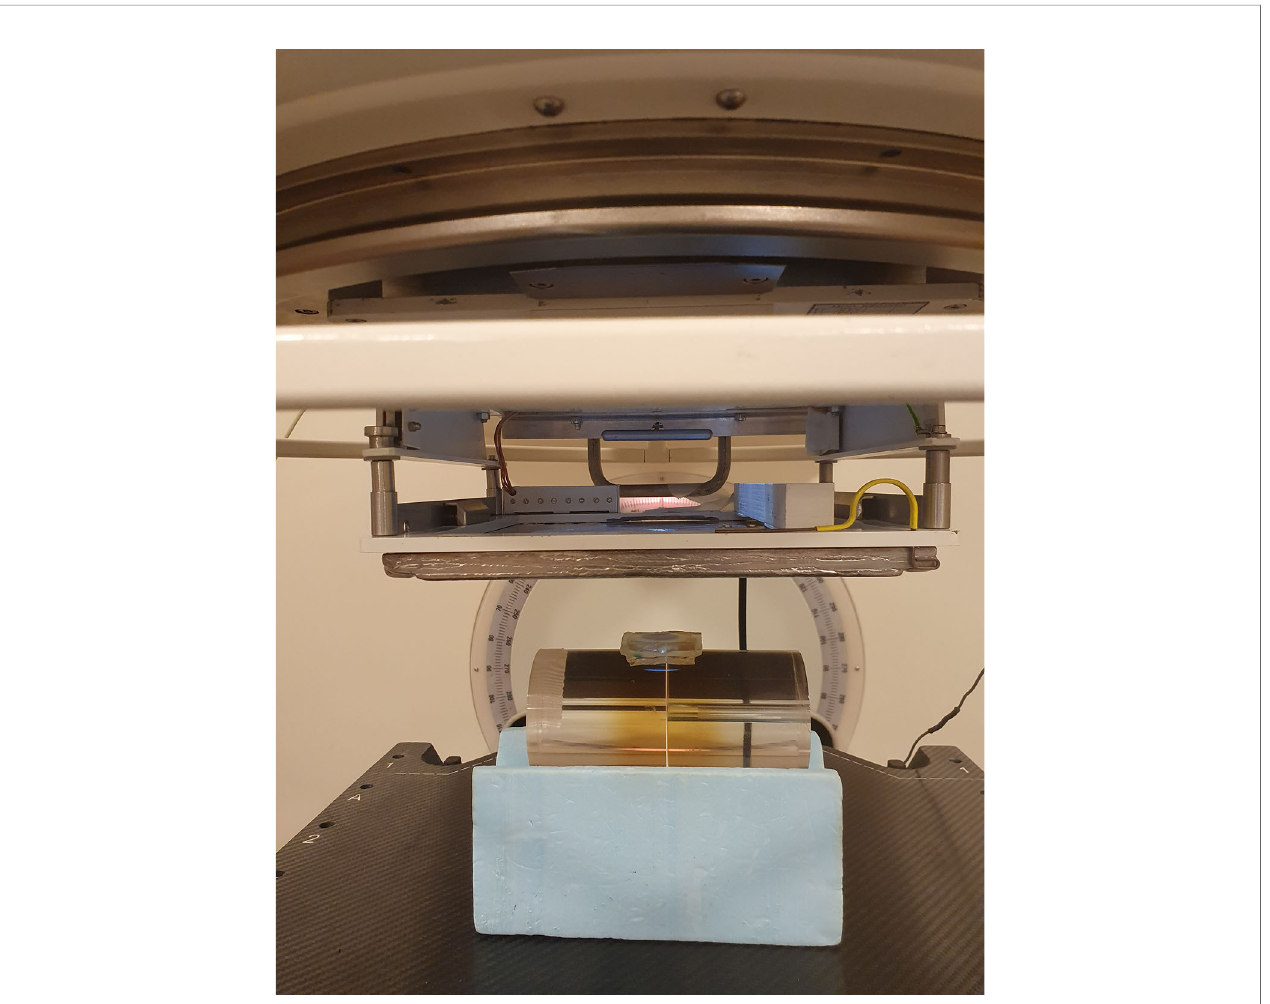
FIGURE 1 | In preparation for each patient treatment, measurements with radiochromic fi lm were performed in phantoms mimicking the treatment geometry, to determine the total dose as well as the dose-per-pulse and number of pulses to be delivered to the patient. A Farmer-type ion-chamber positioned in a customized holder in the electron applicator was used as an output